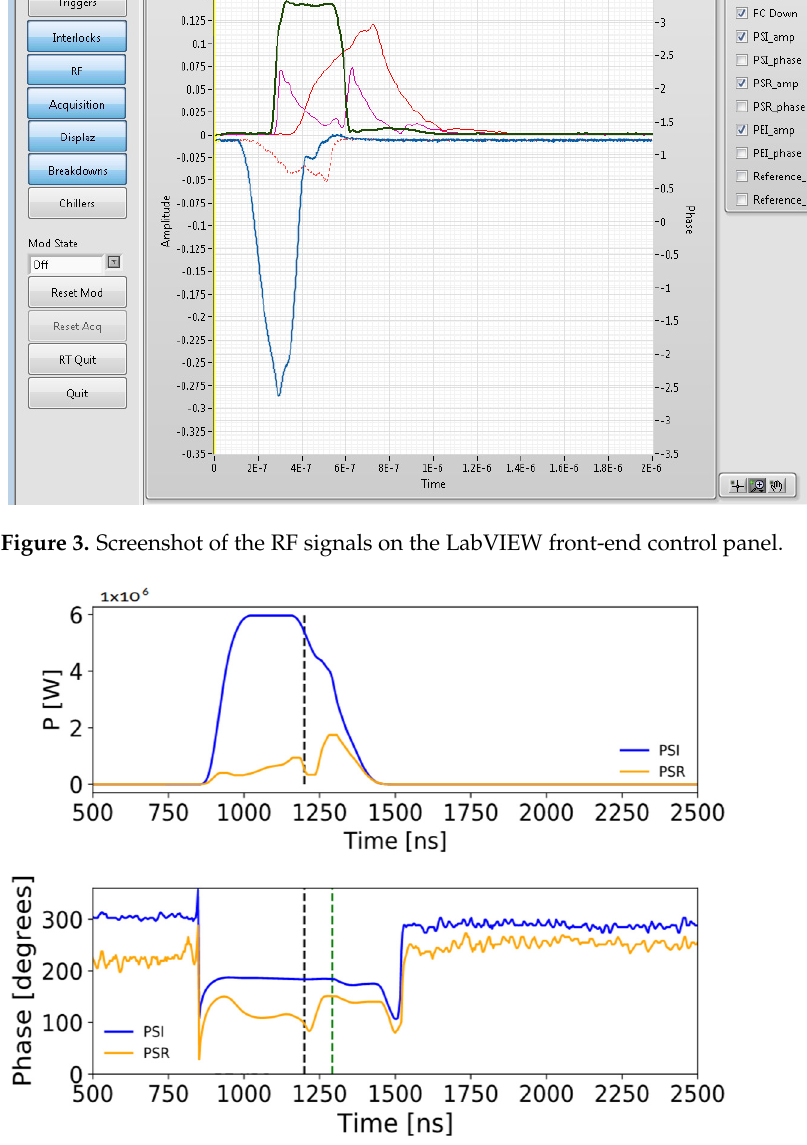
Figure 4. Power structure incident (PSI, blue) and power structure reflected (PSR, orange) pulse amplitudes (top plot) and phase (bottom plot) signals obtained after offline processing. The trigger of the breakdown is indicated with a black dash line and the maximum of reflected power with a green dashed line, which are the time instants that will be used for reflectometry analysis.